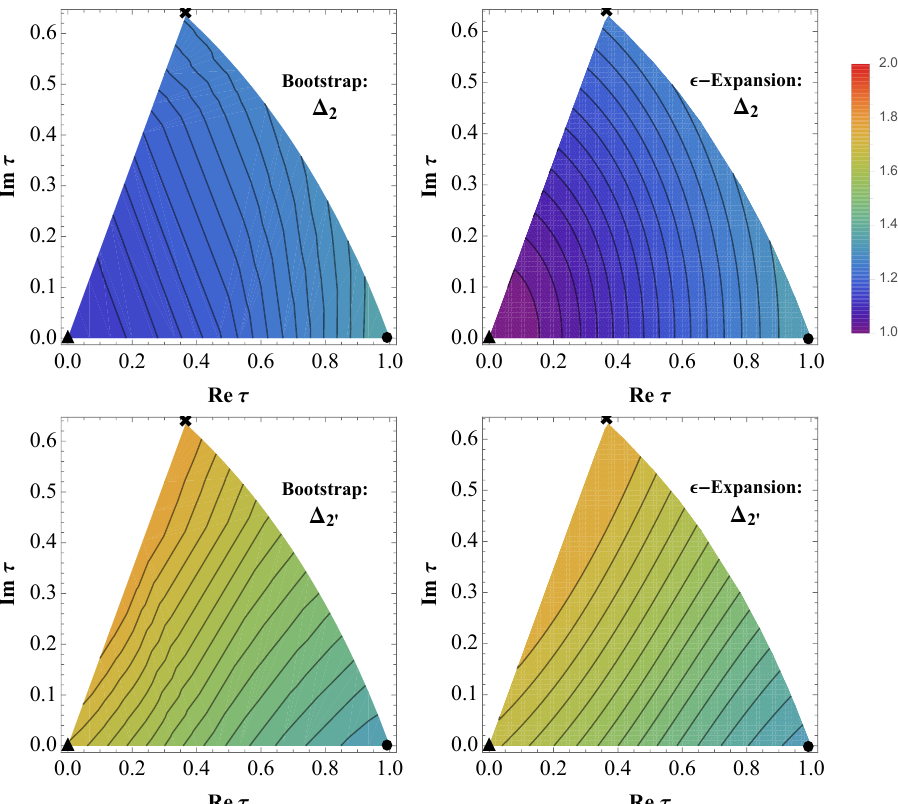
Figure 7 . Left: upper bounds on the doublet scaling dimensions (cid:1) 2 and (cid:1) 2 0 for all (cid:28) in the fundamental domain F de(cid:12)ned in (cid:12)gure 1, computed using the G (cid:13)avor symmetry crossing equations with (cid:3) = 19. Right: resummed 3-loop 4 (cid:0) " -expansion values for these same quantities. In all plots the cross, circle, and triangle denote the enhanced symmetry points (cid:28) = 1 cWZ 3 , and XYZ models